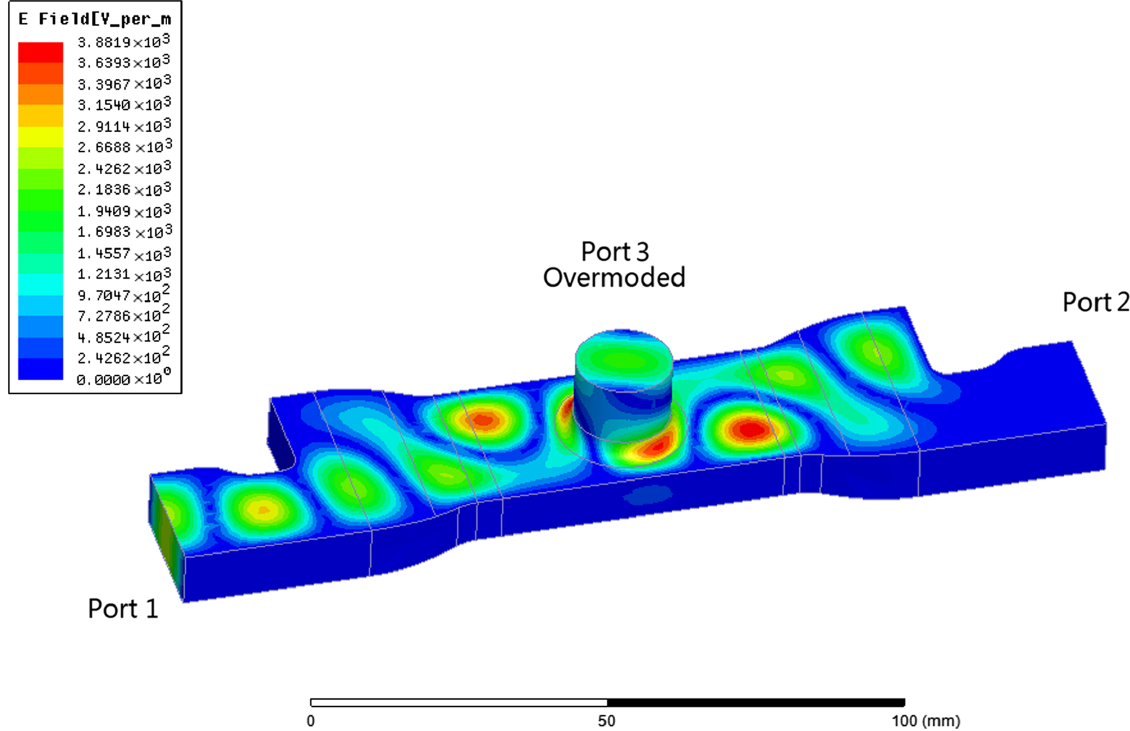
FIG. 7. A snap shot of electric field on assembly of OMT dual polarizing circular converter. The input power on port1 is 1 W in form of TE10 modes. Port 1 and port 2 are standard WR90 rectangular waveguide while port 3 is the circular